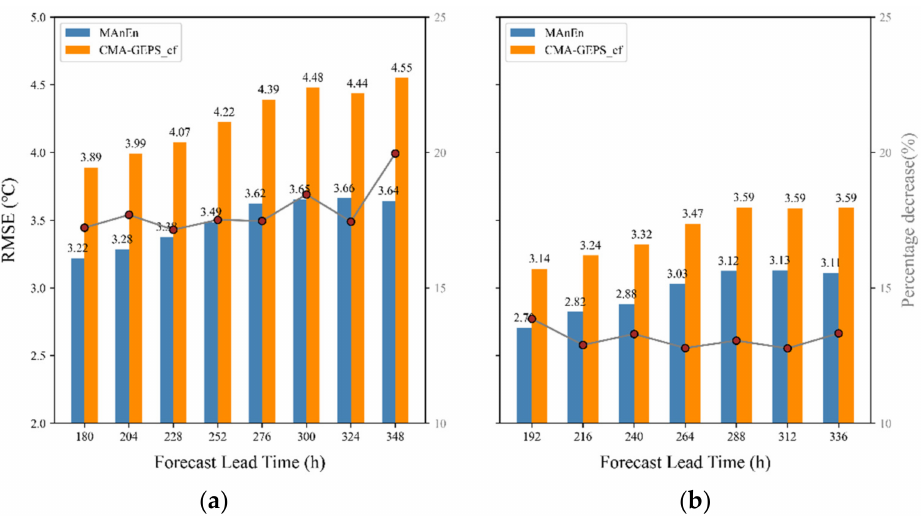
Figure 4. RMSE and percentage decrease of the analog ensemble averaging forecasts and model forecasts. ( a ) Daily 12 h forecast for 7–14 d; ( b ) daily 00 h forecast for 8–14